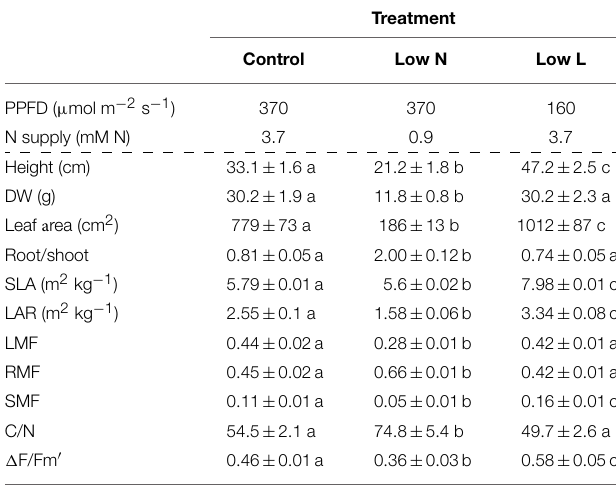
TABLE 1 | Effect of light and nutrient reduction on H. halimifolium .